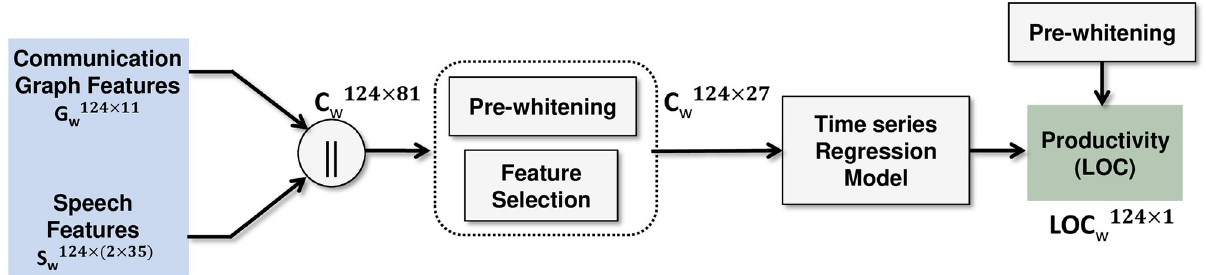
Fig 2. Prediction process